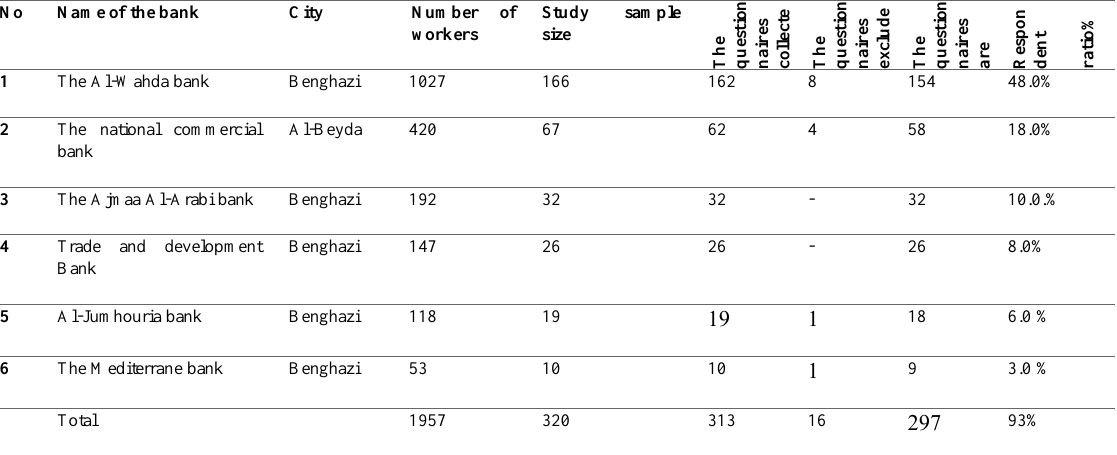
Table 1 : The study population and study